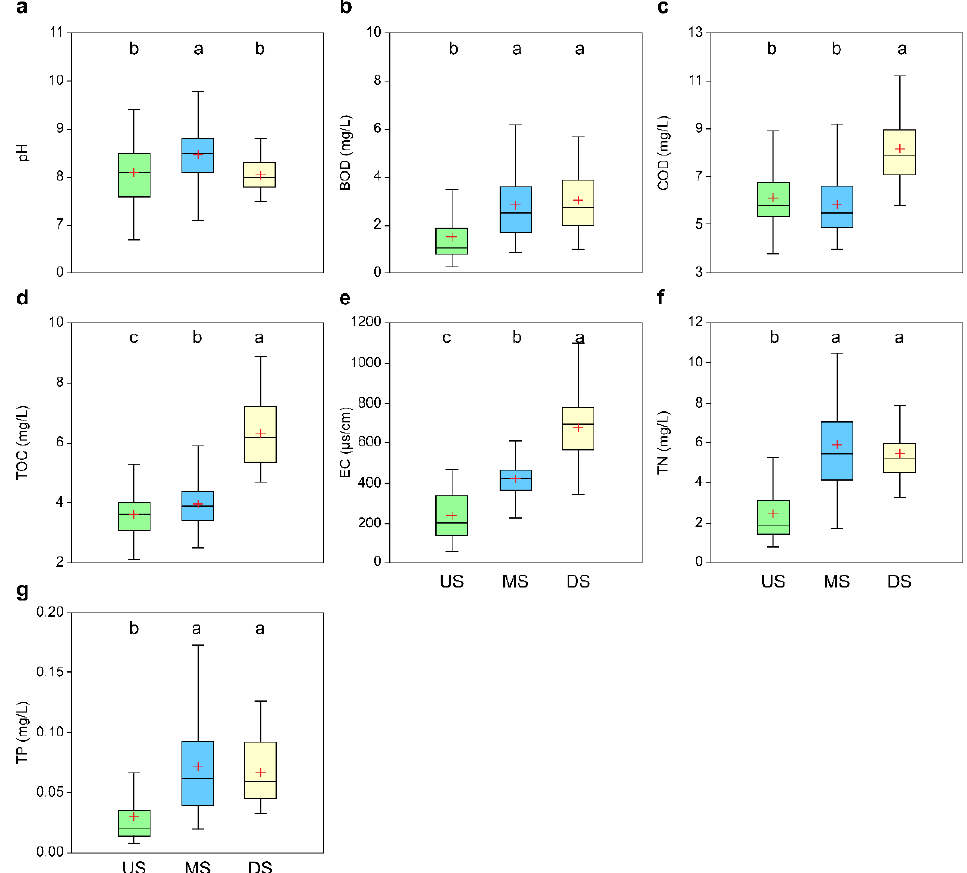
Figure 7. Box plots of the spatial stepwise mode discriminant function. The middle line of each box represents the median value, the lower line represents the first quartile (25%), the upper line represents the third quartile (75%), the lower bar represents the minimum (median-1.5 × interquartile range; IQR), and the upper bar represents the maximum (median + 1.5 × IQR); the red cross mark indicates the average value. The IQR is the third quartile minus the first quartile, and the letters above the box plot represent the results of the Scheffe Test ( p < 0.05). ( a ): pH; ( b ): biochemical oxygen